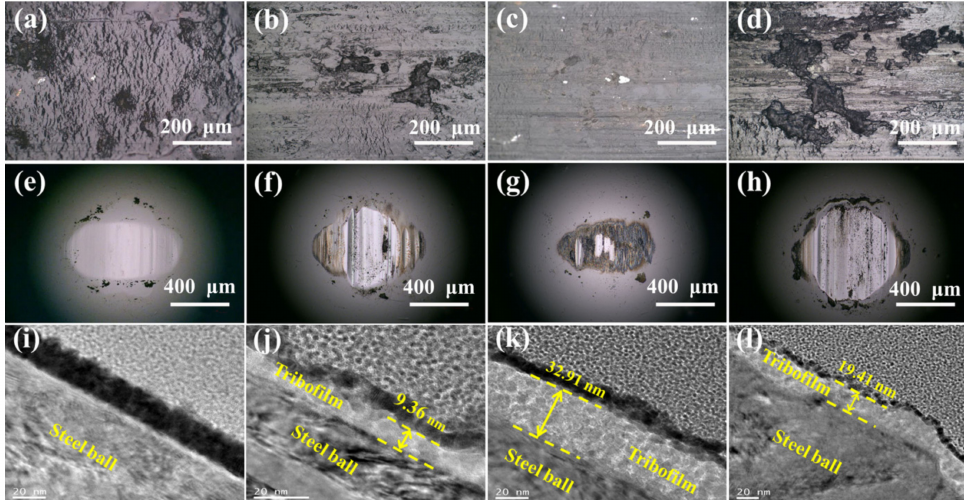
Figure 9. Optical photographs of worn surfaces and wear scars of corresponding counterpart balls sliding against the nanocomposite coatings, as well as transmission electron microscope (TEM) morphologies of tribofilm, ( a , e , i ) S-C0, ( b , f , j ) S-C2, ( c , g , k ) S-C4, ( d , h , l )